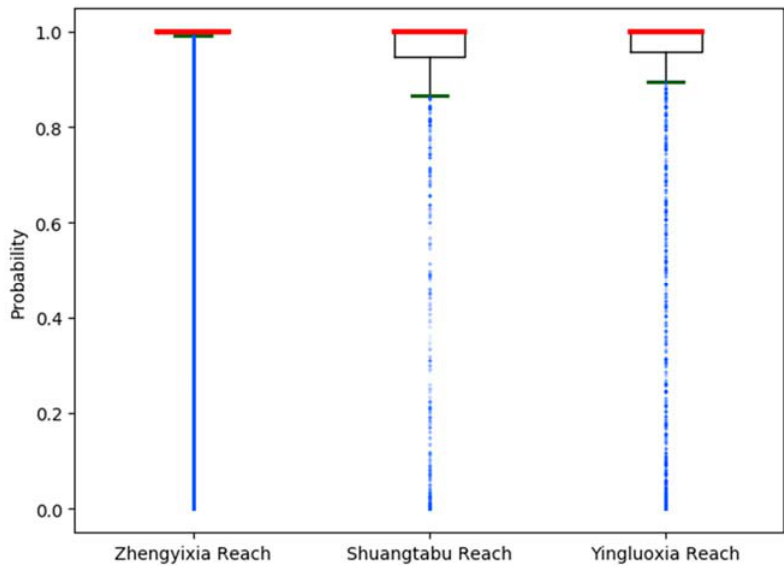
Figure 7. The boxplots of probability values obtained by posterior probability support vector machine (PPSVM) in the referencing water areas.